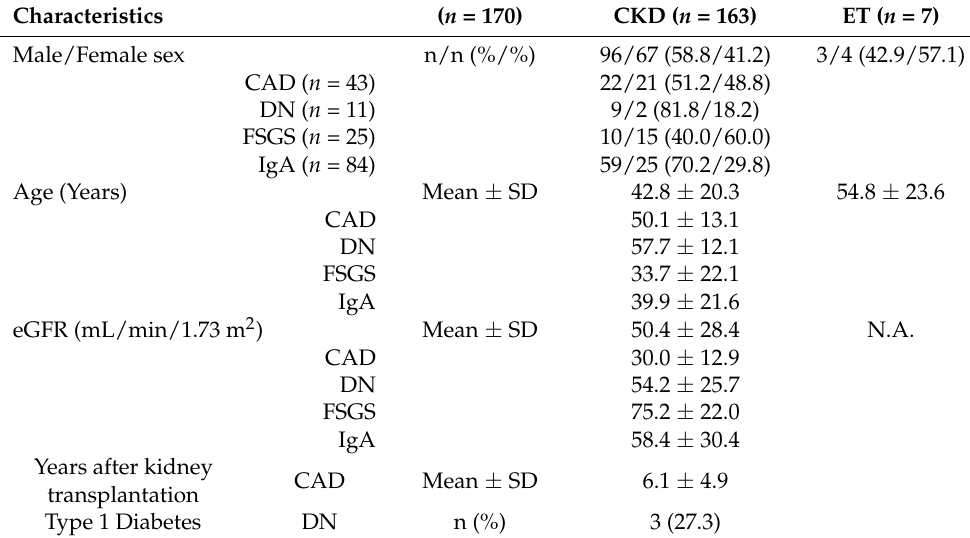
Table 1. Baseline characteristics of patient